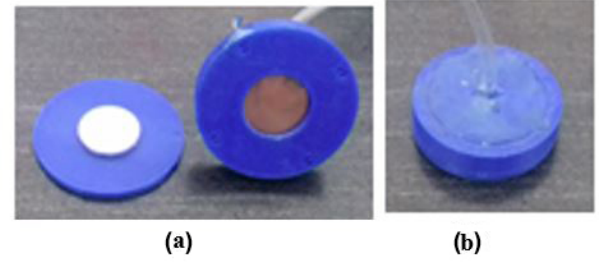
Figure 5. 3D-printed pictures of the sensor: (a) different parts of the sensor and (b) the assembled